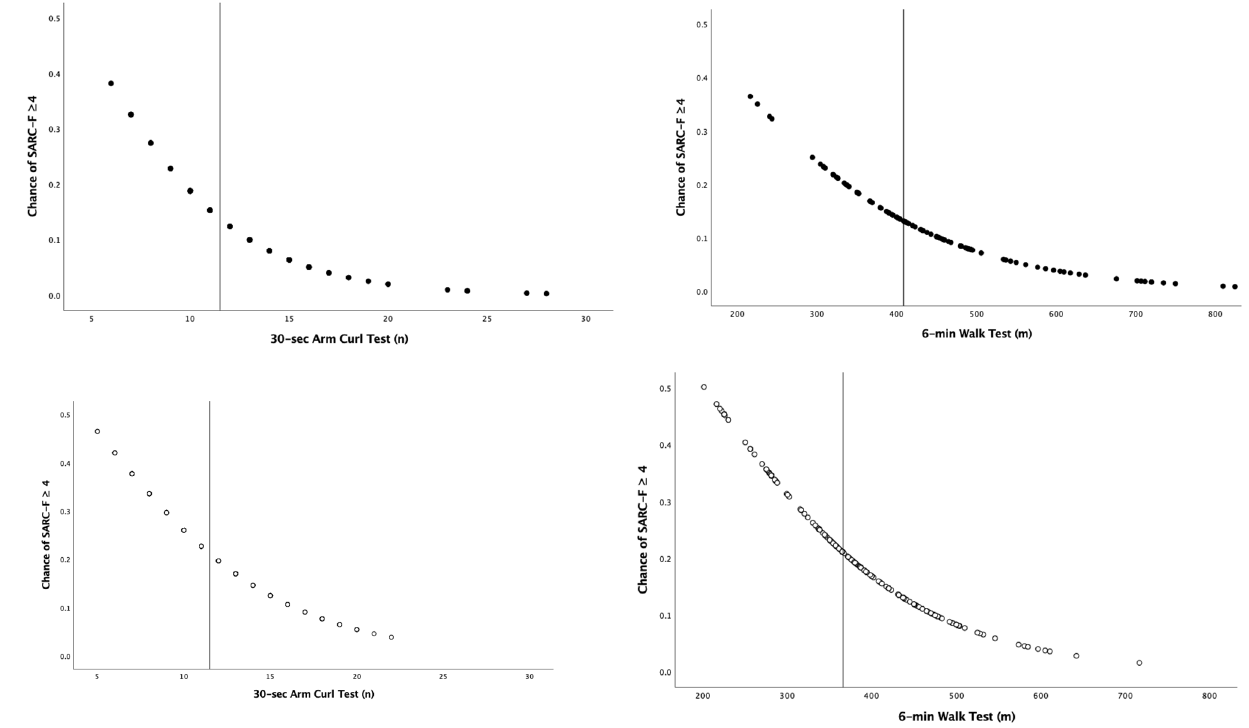
Figure 1. Probability of SARC-F ≥ 4 points according to the 30-s arm curl test and 6-min walk test (men, black dots ( top ); women white dots ( bottom )).